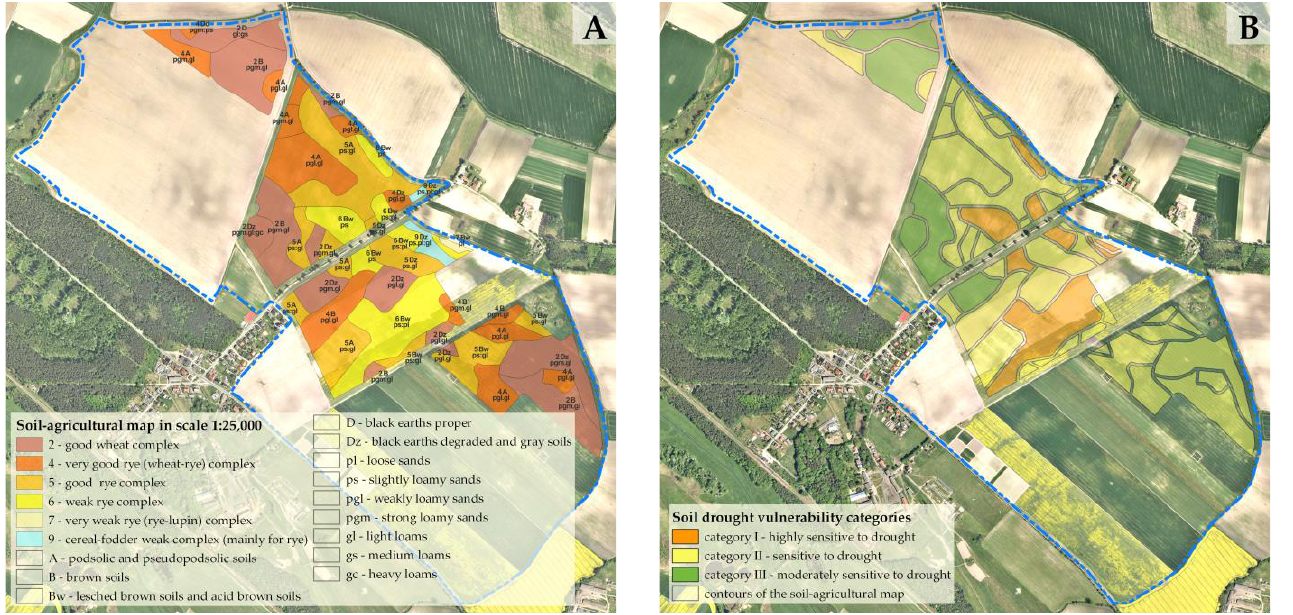
Figure 2. Soil-agricultural map ( A ) and soil drought vulnerability category map ( B ) for the study area in Baborówko Experimental Station.